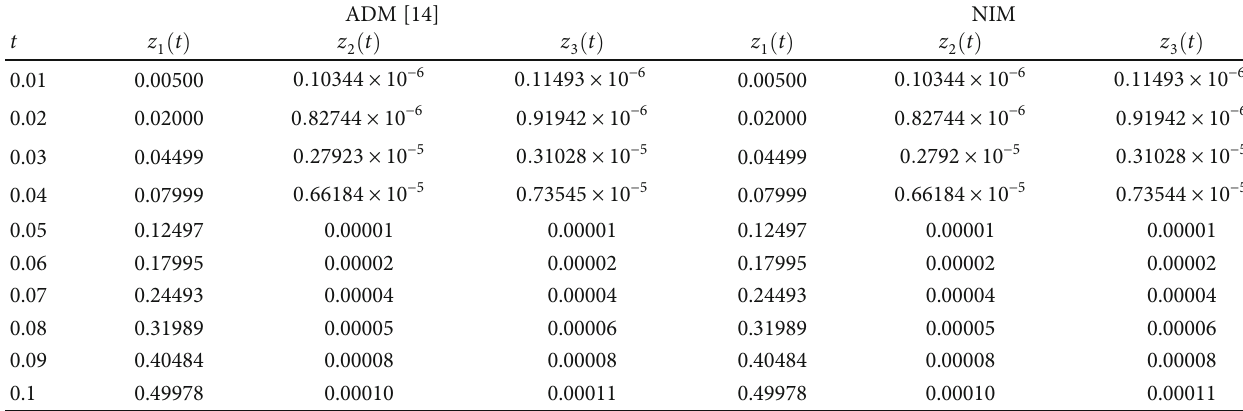
Table 3: Numerical comparisons between ADM and NIM for the step input model.